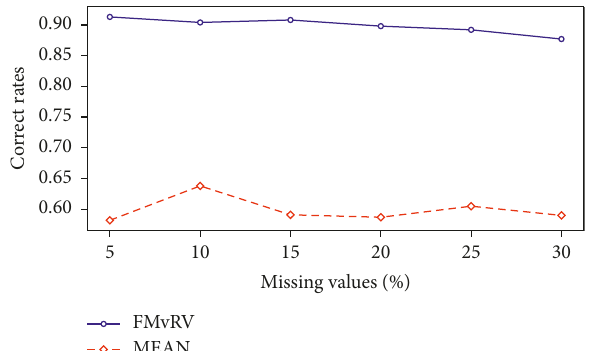
Figure 6: Comparison of correct rates of Algorithm FMvRV and Algorithm MEAN.